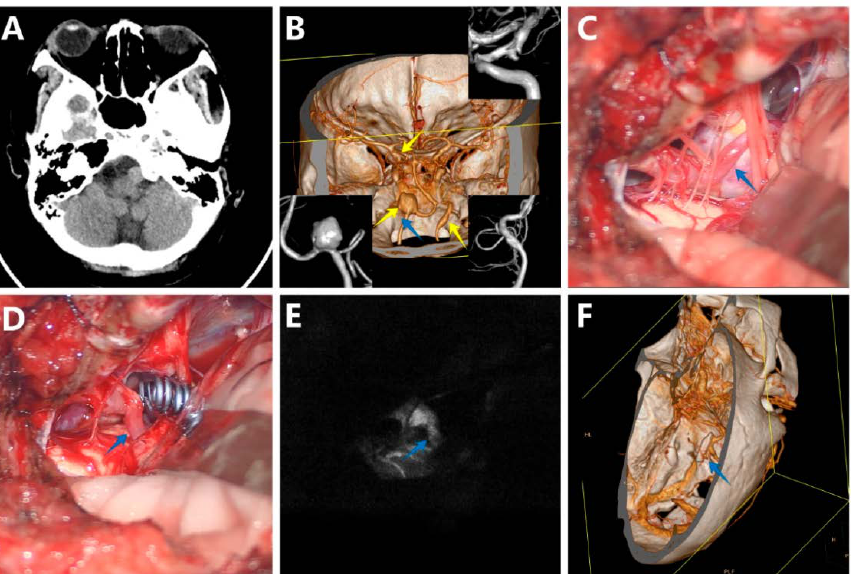
Figure 3. A woman with a large saccular aneurysm on the V4 segment of the right vertebral artery (VA), a small saccular aneurysm on the C7 segment of the left internal carotid artery (ICA), and a fusiform aneurysm located in the V3 segment of the left VA. ( A ) The CT scan showed a round-like mass located in the front of the medulla oblongata; ( B ) The digital subtraction angiography (DSA) and CTA disclosed a large saccular aneurysm located in the V4 segment of the right VA, a small saccular aneurysm located in the C7 segment of the left internal carotid artery, and a fusiform aneurysm located in the V3 segment of the left VA; ( C ) The aneurysm, VA, and posterior inferior cerebellar artery (PICA) before clipping; ( D ) The aneurysm, VA, and PICA after clipping; ( E ) Intraoperative indocyanine green videoangiography confirmed no residual aneurysm and patency of VA and PICA; ( F ) Postoperative CTA further demonstrated complete obliteration of the aneurysm. (The yellow arrows show the aneurysm, and the blue arrows show the